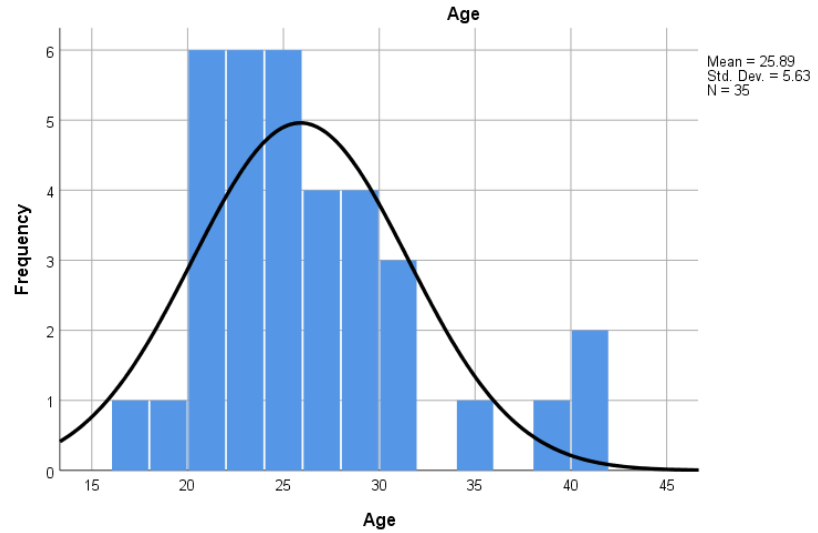
Figure A1. Distribution of Age of workers.